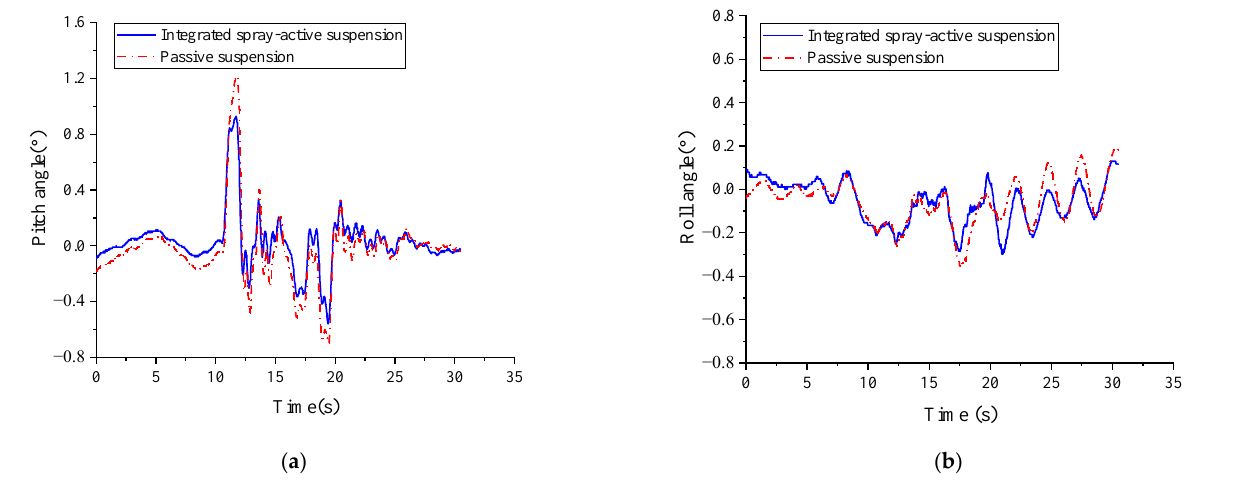
Figure 13. ( a ) Pitch angle comparison curve of wheel-crossing obstacle on one side; ( b ) roll angle comparison curve of wheel-crossing obstacle on one side.